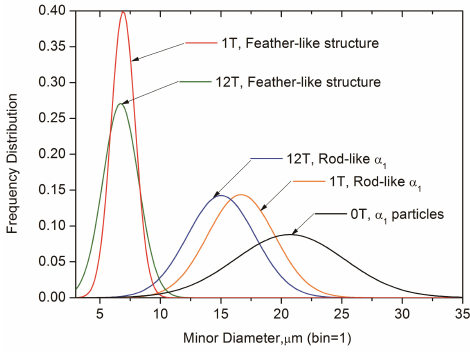
Figure 4. The frequency distribution of diameter for α 1 rods in Fe ‐ Cr ‐ Co alloys, the normal distribution curves were fitted according to the measured data.